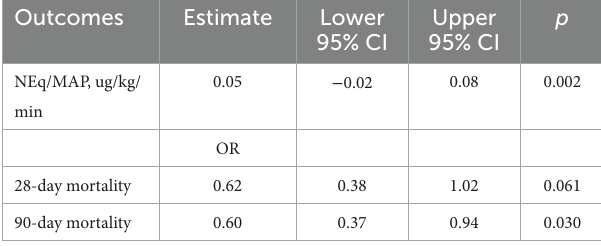
TABLE 4 Primary and secondary outcomes after generalized linear mixed model (GLMM) analysis. * Outcomes